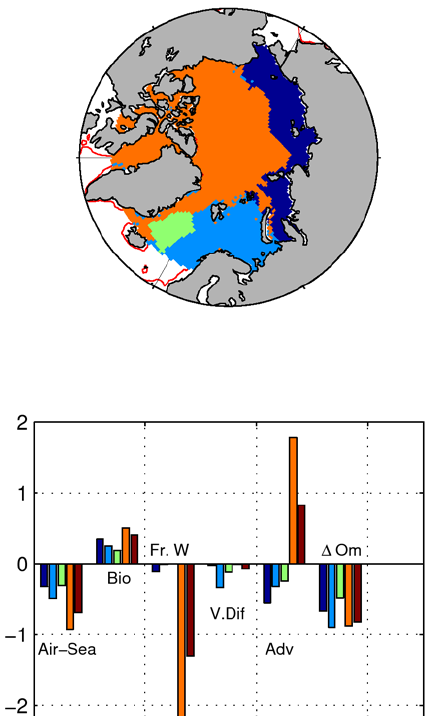
Fig. 5. (a) Spatial extent of four provinces showing qualitatively different balance of the main factors contributing to the (cid:127) a de- cline over the 21st century and identified as Siberian shelves (dark blue), Atlantic inflow (light blue), Nordic minimum (green), fresh- water province (orange) – see text; (b) projected changes in the an- nual mean difference in (cid:127) a from 2000 to 2099 in the top 100m of the Arctic Ocean (north of 66 ◦ N, dark red bars) and four province shown in (a) . The total change ( 1 Om) is divided into contribution by air–sea gas exchange (Air–Sea), biology (Bio), freshwater fluxes (Fr.W), vertical diffusivity (V.Dif), and advection (Adv).